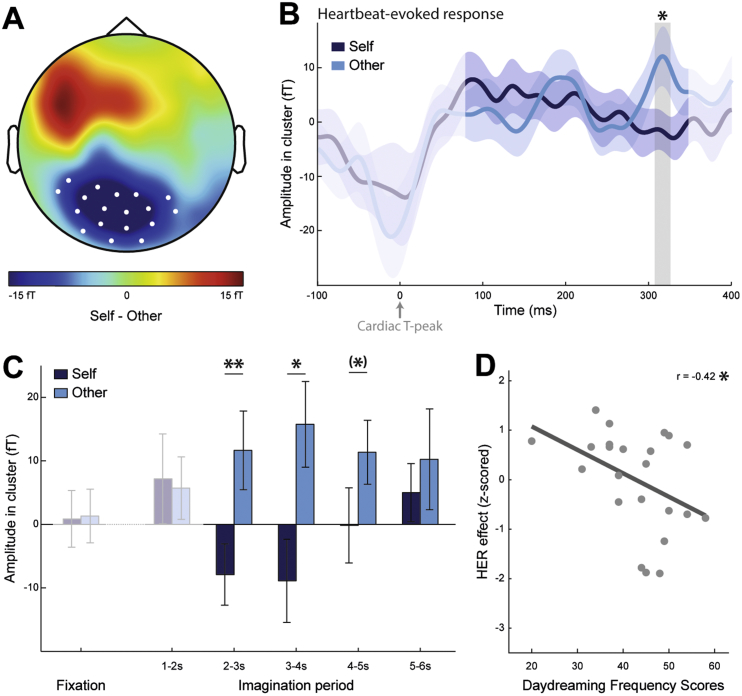
Differential Heartbeat-Evoked Responses (HERs) for imagining oneself (Self) or a friend (Other). A, Topographical map of the HER difference between Self and Other conditions, grand-averaged across 23 participants, in the 307–326 ms time window in which a significant difference was observed (Monte-Carlo p = 0.012). White dots represent the sensors contributing to the significant cluster. B, Time course of the HER (±SEM) for Self and Other, averaged over the sensors marked in white in A. The signal that might be residually contaminated by the cardiac artefact appears in lighter color and was not included in the epoch analyzed. The grey area represents the time window in which a significant difference was observed. C, Temporal evolution of the HER effect, during the imagination period. Amplitude in cluster corresponds to the average brain activity in the T-peak locked time window and sensors revealing a significant HER effect (sensors indicated in A, time window indicated in B). Cluster amplitude was computed for HERs occurring during fixation (1–1.3s), and during the imagination period divided in five windows of 1 second (1–2s, 2–3s, 3–4s, 4–5s, 5–6s). The largest cluster amplitude differences between Self and Other were observed in the windows 2–3s and 3–4s. D, Correlation between the size of the HER effect and Daydreaming Frequency Scores (p = 0.049). HER effect was computed for each participant as the difference between the HER cluster amplitude for Self minus the HER cluster amplitude for Other, z-scored across participants, for HERs in 2–4s of imagination period. Each dot represents one participant. **: p < 0.01, *: p < 0.05, (*): p < 0.1.